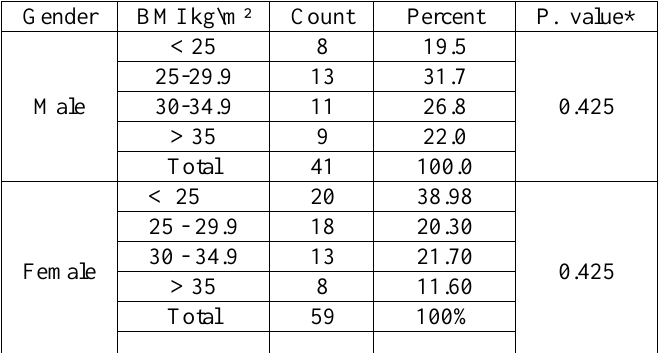
Table 2: Distribution of patients by gender and body mass index (BMI)